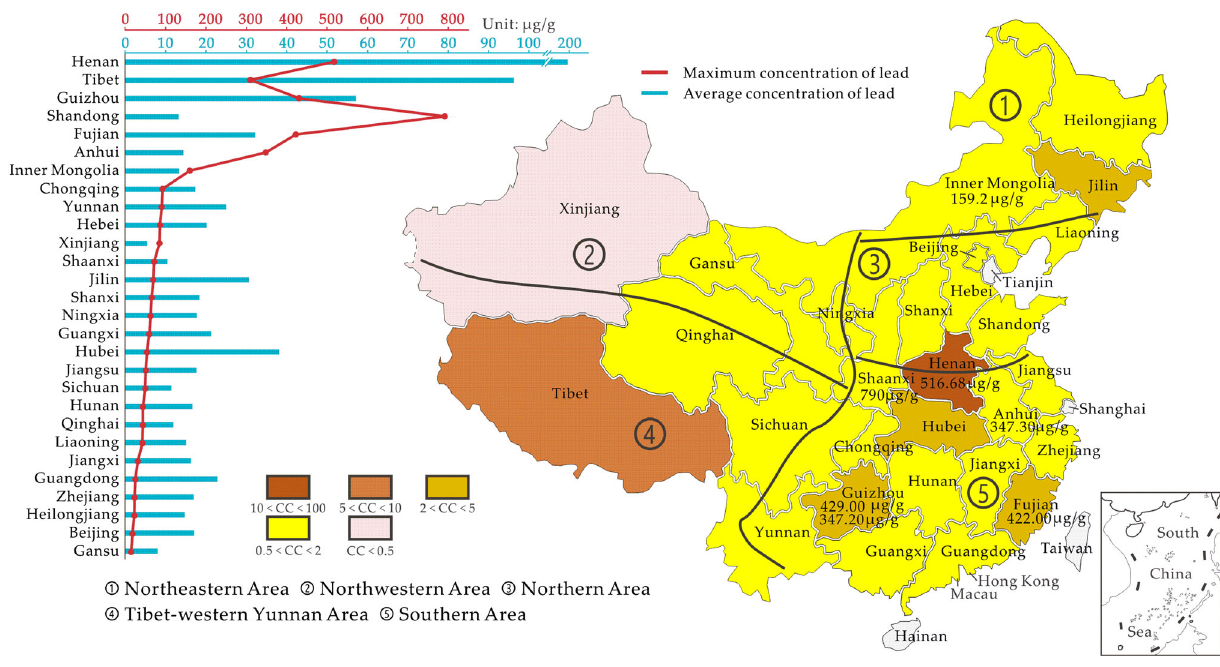
Fig. 1 Distribution of lead in Chinese coals. CC: concentration coefficient